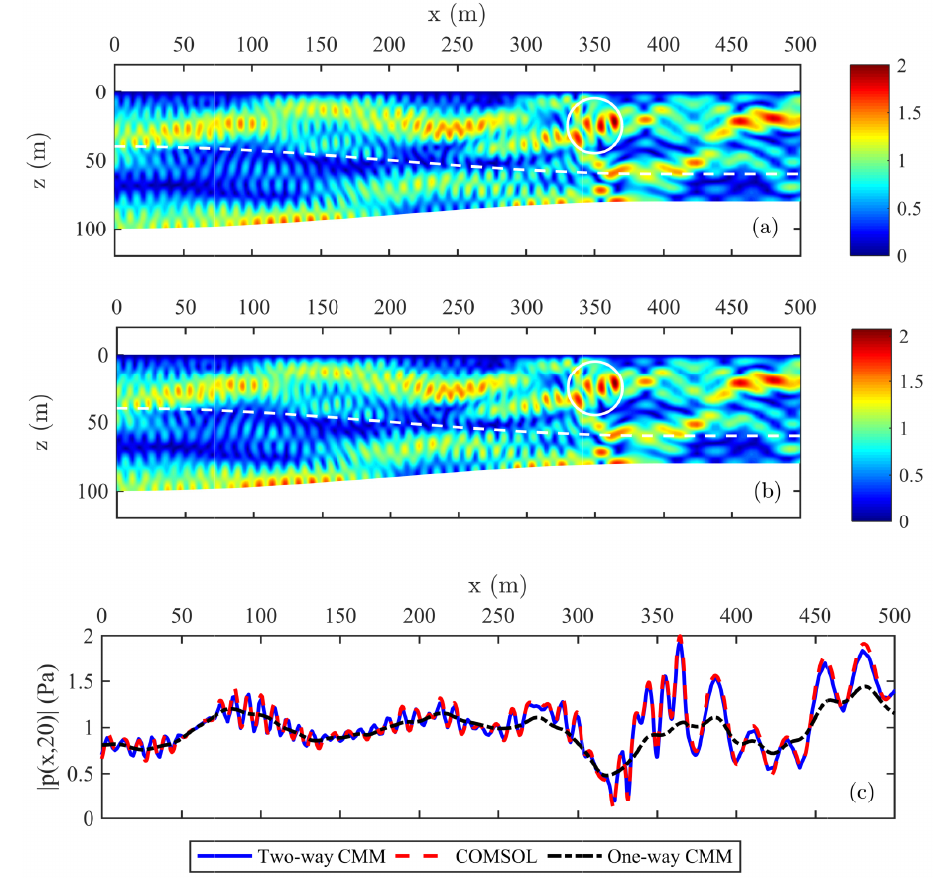
Figure 2. (Color online) Sound field (acoustic pressure modulus) in a two-layer waveguide with a penetrable scatterer. ( a ) Sound field computed by the present two-way coupled mode method with N = 20. ( b ) Sound field computed by COMSOL. ( c ) Acoustic pressure modulus distribution along x direction at z = 20. The waveguide is forced by a distributed source at